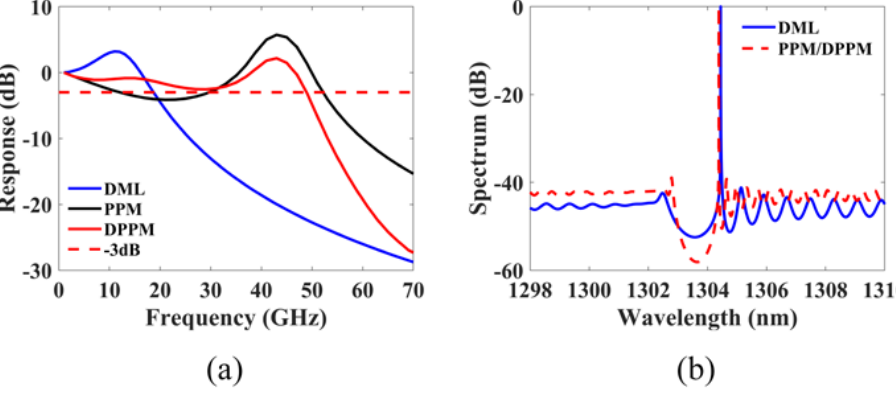
Figure 9. Simulation results: ( a ) Modulation response with P bias = 12 mW; ( b ) Lasing